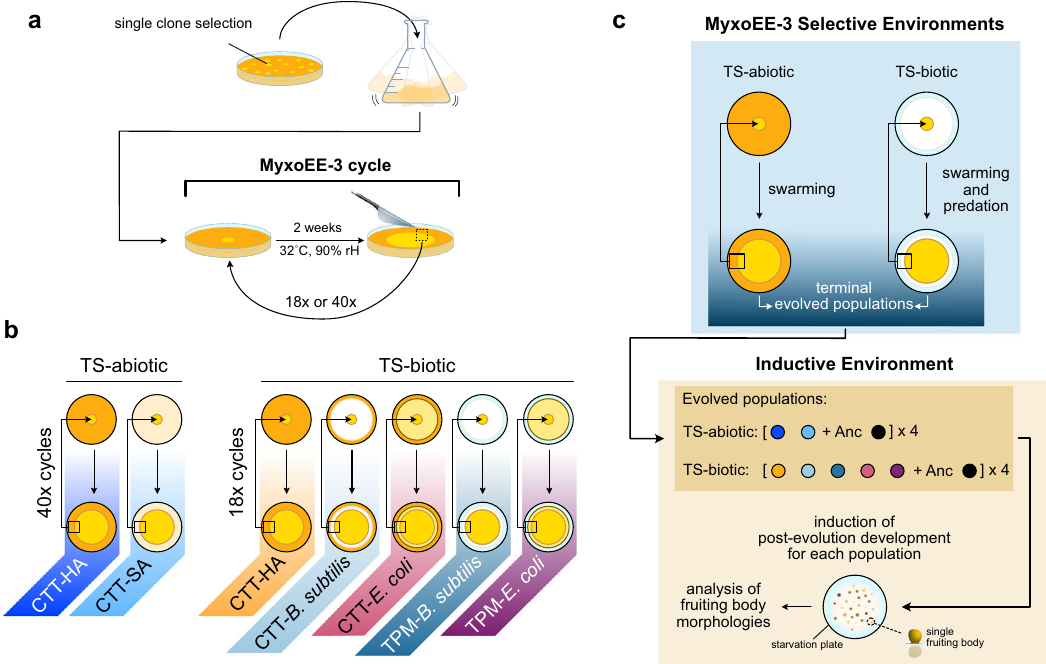
Fig. 1 Overview of MyxoEE-3 treatments and time-points examined here for latent evolution of fruiting body morphology. a MyxoEE-3 initiation and cycling scheme (adapted from ref. 104 ). Ancestral subclones (collectively 'Anc') were isolated, grown in liquid, and used to start MyxoEE-3 populations (see Supp. Table 1). During each evolutionary cycle, populations (yellow circles) were allowed to swarm for 2 weeks at 32 °C and 90% rH before a small rectangle at the furthest point from the swarm center was cut and transferred upside down to the center of a new plate. Populations examined here underwent either 18 or 40 such cycles according to the speci fi c treatment set (TS). b Overview of MyoxEE-3 treatments relevant to this study subdivided into two treatment sets (TS) — abiotic and biotic. TS-abiotic populations (yellow circles) evolved on either CTT hard agar (CTT-HA, dark orange plates) or CTT soft agar (CTT-SA, beige plates) for a total of 40 cycles. TS-biotic populations evolved on either CTT-HA only (same as CTT-HA in TS-abiotic) or on CTT-HA (dark orange plates) or TPM-HA (light blue plates) with lawns of either Bacillus subtilis (white area) or Escherichia coli (light yellow area). The TS- biotic populations were examined after 18 MyxoEE-3 cycles. c Scheme representing the distinctive experimental selective and inductive environments that characterize this study. Populations evolved in a range of different environments (selective environments) (panel b ), where the abiotic (TS-abiotic) and biotic (TS-biotic) sources of selection acted on motility and/or predation during vegetative growth. Importantly, while exposed to selection during MyxoEE- 3, transferred populations did not undergo fruiting body formation, such that development per se was hidden from the selection. Post-evolution development was subsequently induced on starvation plates (inductive environment) in all MyxoEE-3 terminal populations independently to study the latent evolution of fruiting body